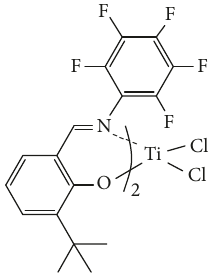
Figure 1: Bis-[N-(3-tert-butylsalicydene)-2,3,4,5,6-pentafluoroani- linate]TiCl 2 catalyst used in this